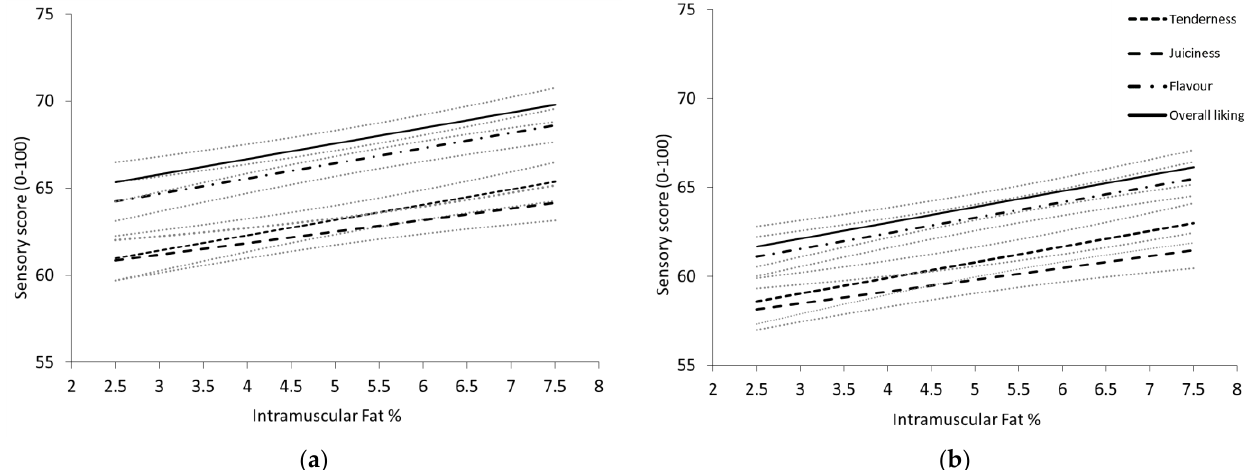
Figure 1. Relationship between intramuscular fat (%) of the loin muscle and tenderness, juiciness, liking of flavour and overall liking scores of the ( a ) shoulder cut; ( b ) leg cut. Lines represent the least square means of each cut (±SE) across an increasing intramuscular fat % range.